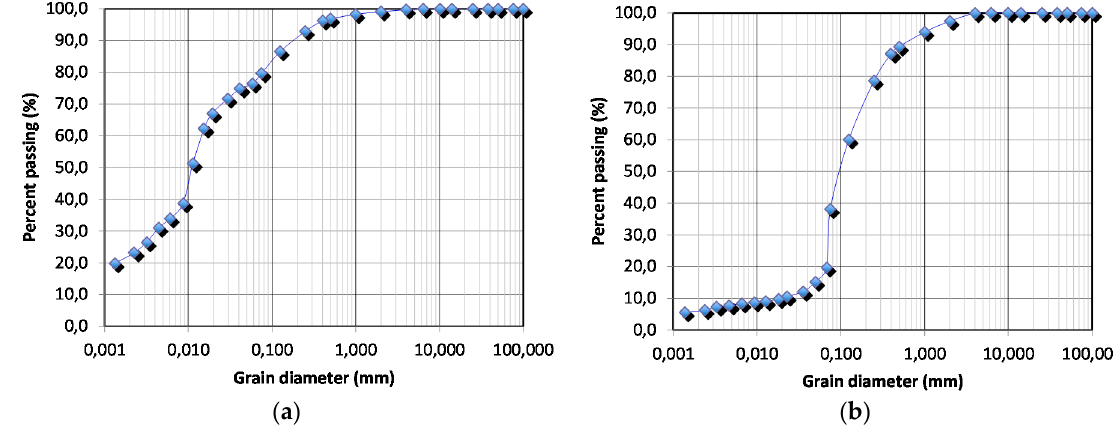
Figure 10. Grain size distribution of the soils used for the experiments: ( a ) fine-textured soil (Silty Loam, according to USDA); ( b ) coarse-textured soil (Loamy Sand, according to USDA).